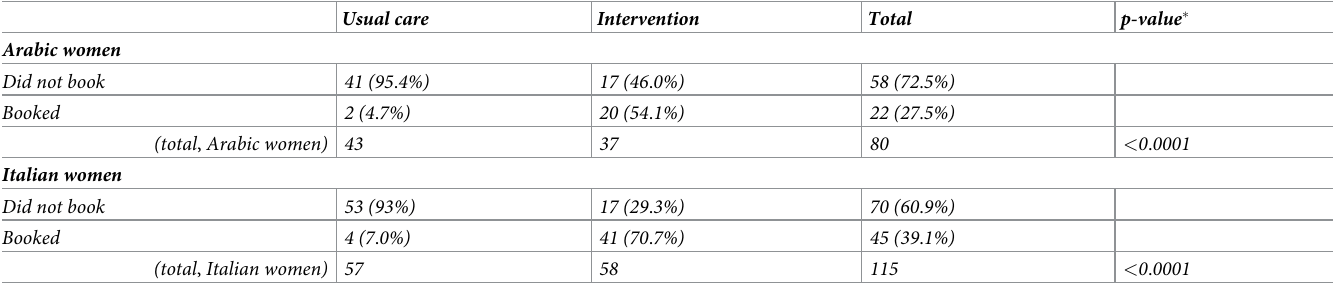
Table 5. Frequency and proportion of booking a screening appointment within 14 days in the phone call trial by language group. Usual